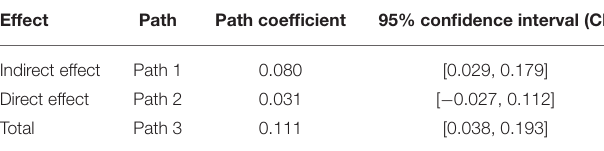
TABLE 7 | Mediating effect of professional identity on perceived organizational support and emotional